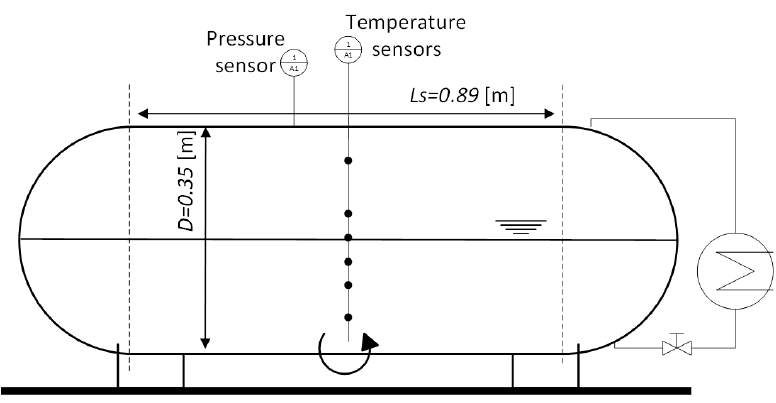
Figure 2. Thermal tank and the instrumentation.